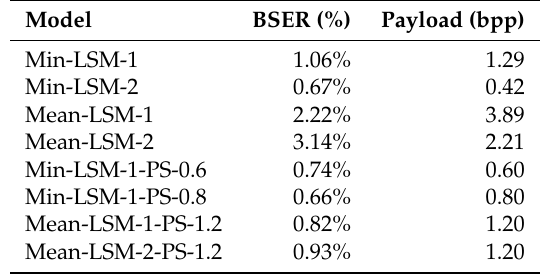
Table 1. Different embedding strategies comparison.